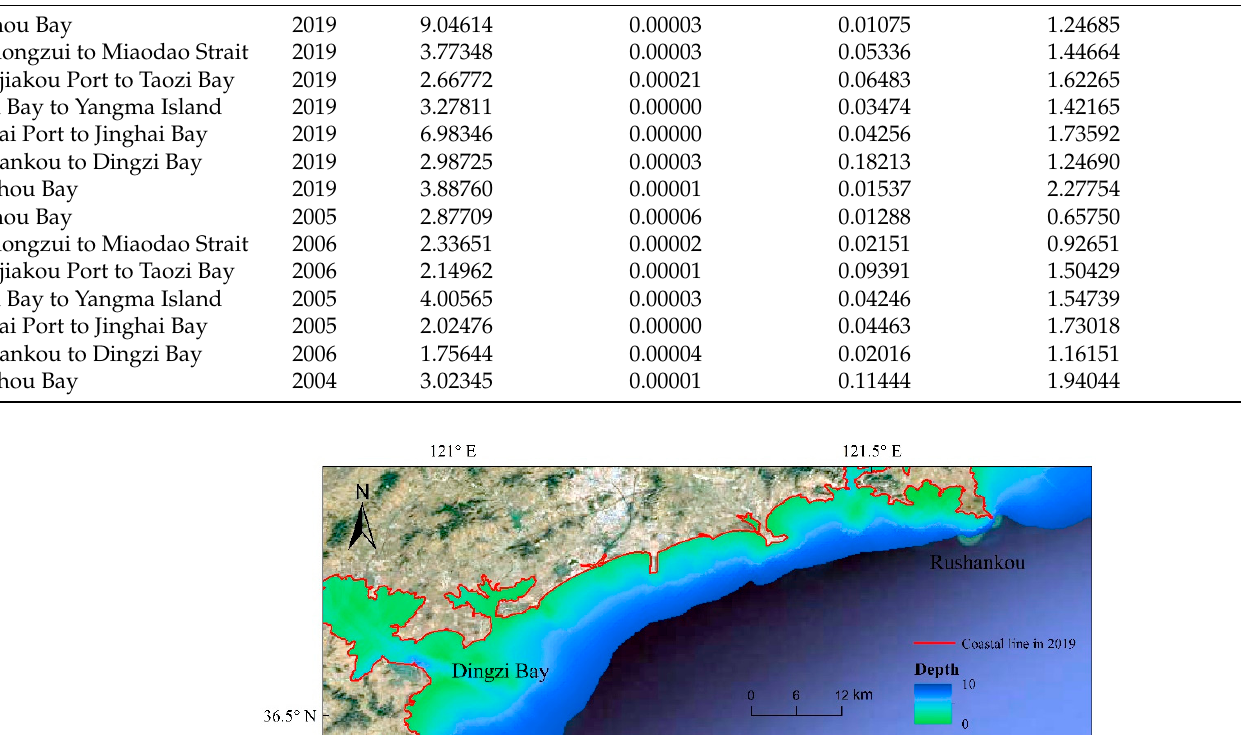
Figure 4. Digital elevation model of Rushankou to Dingzi Bay, 2019.